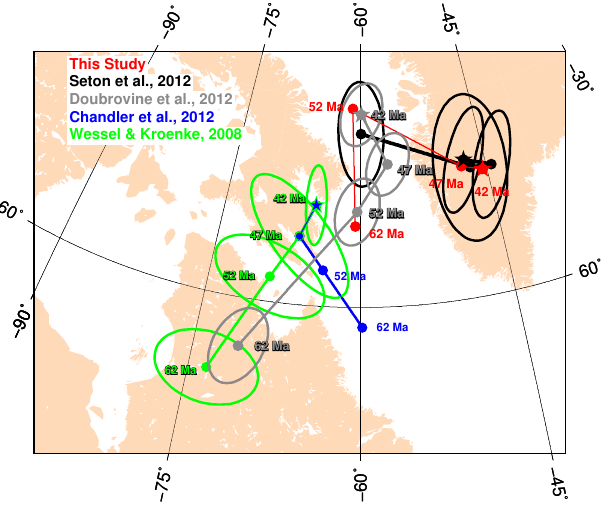
Figure 6. Finite reconstruction pole locations for the absolute mo- tion of the Pacific plate at each of the model times. The five different absolute reference frames are coloured as in the legend. Stars rep- resent the 42Ma Euler poles and progressive points are the 47, 52 and 62Ma poles. Present day continents are overlain in peach for reference. The BEM-Earth reconstruction poles are derived from the addition of the stage rotations for each geodynamic model run to the 42 Ma Pacific absolute motion pole from Seton et al. (2012). Projected error ellipses are determined from each model’s published covariance